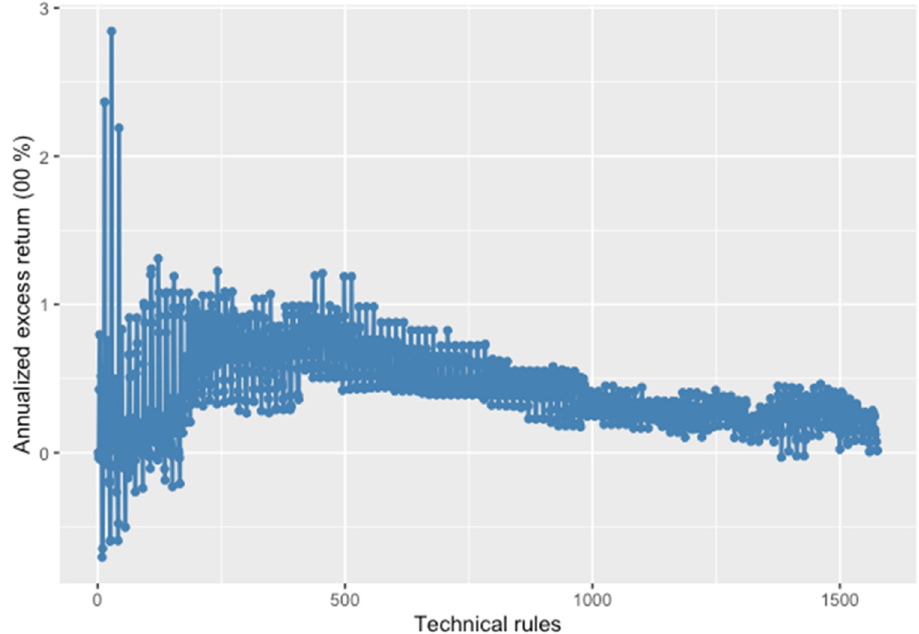
Figure 5. Annualized excess returns * for all 1575 SMA crossover rules for the Brent market over the